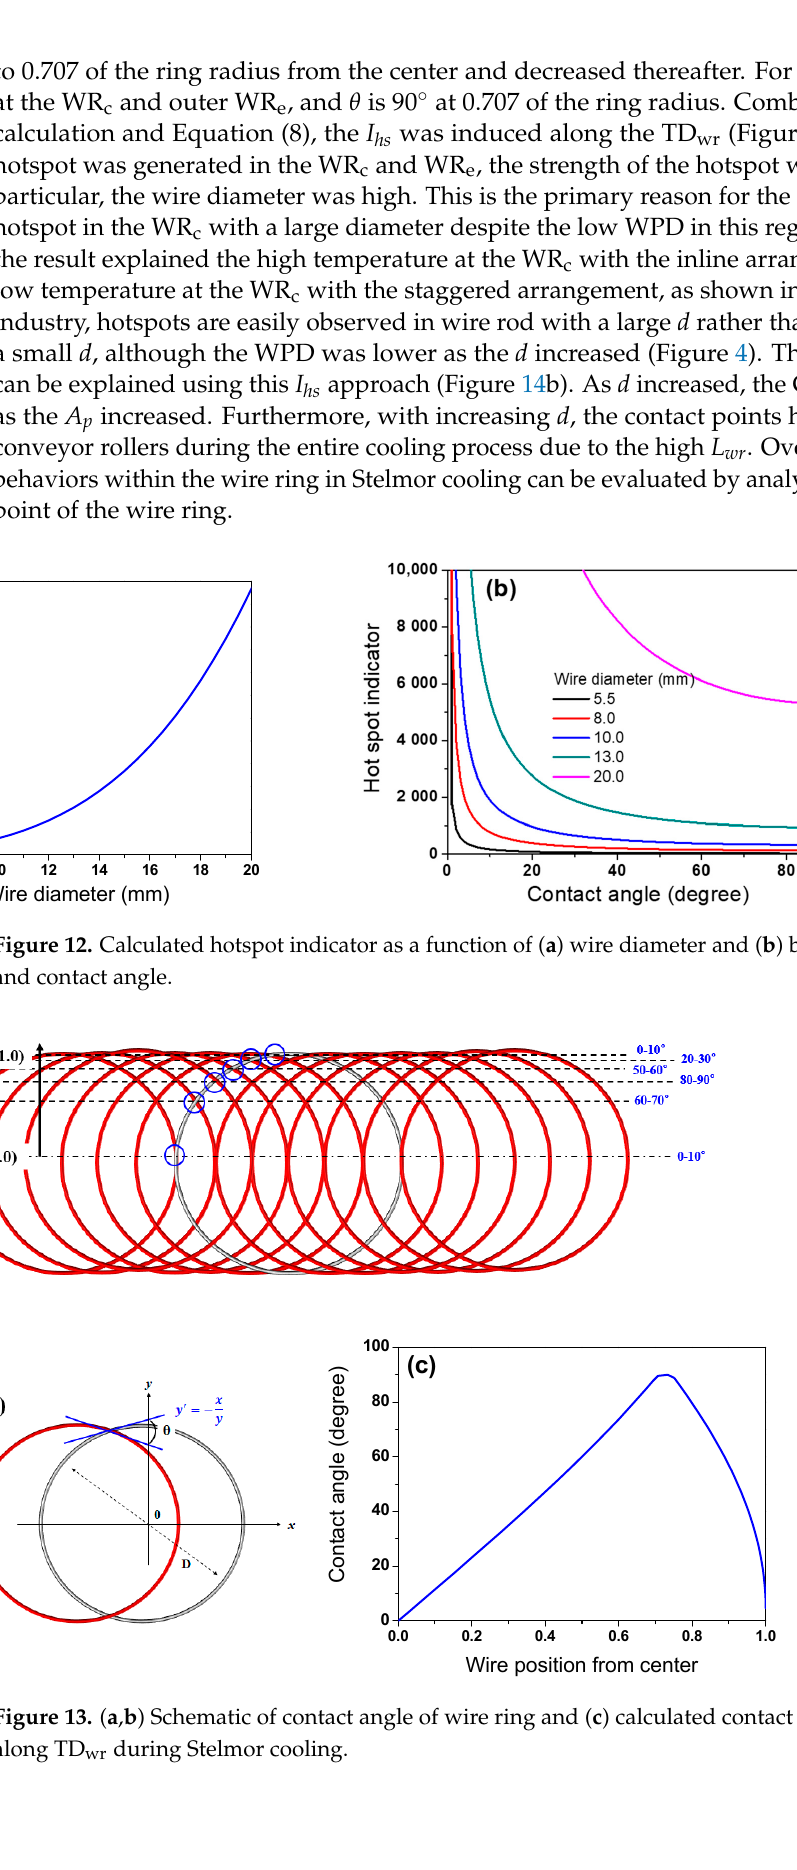
Figure 10. ( a , c ) Schematic and ( b , d ) calculated projection area of wire rod with contact angle and wire diameter.